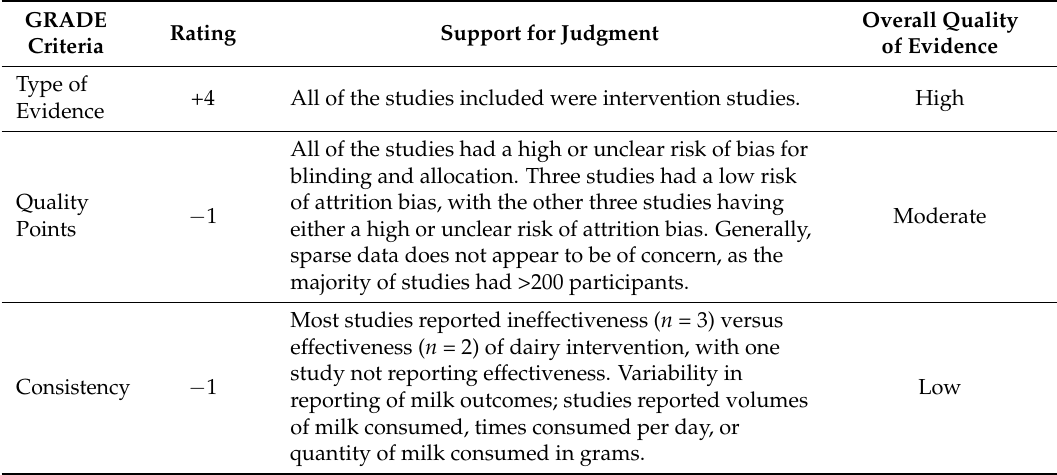
Table 7. Summary of GRADE results for total milk intake outcome ( n = 6). Intervention studies evaluated: Bender et al., 2013 [23]; Korwanich et al., 2008 [26]; Marquis et al., 2014 [27]; Salehi et al., 2004 [31]; Schwartz et al., 2015 [32]; and Vereecken et al., 2009